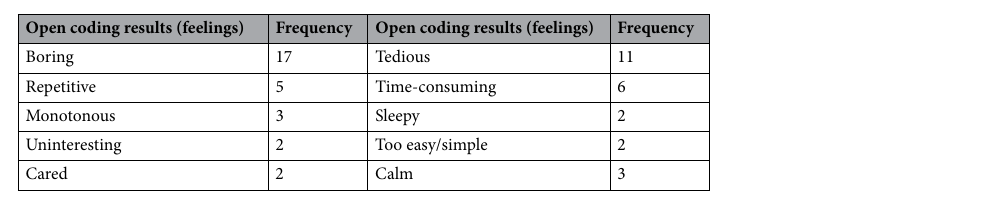
Figure 7. Results on perceived closeness ( a ) and intimacy ( b ) in Experiment 2. Participants perceived a significantly higher level of closeness to agents responding to positive decisions than agents responding to negative decisions. Moreover, participants had a marginally higher level of intimacy with agents responding to positive decisions than agents responding to negative decisions ( + 0.05 < p < 0.06 , ∗ ∗ p < 0.001 , CIs in figures represent 95 % CIs).